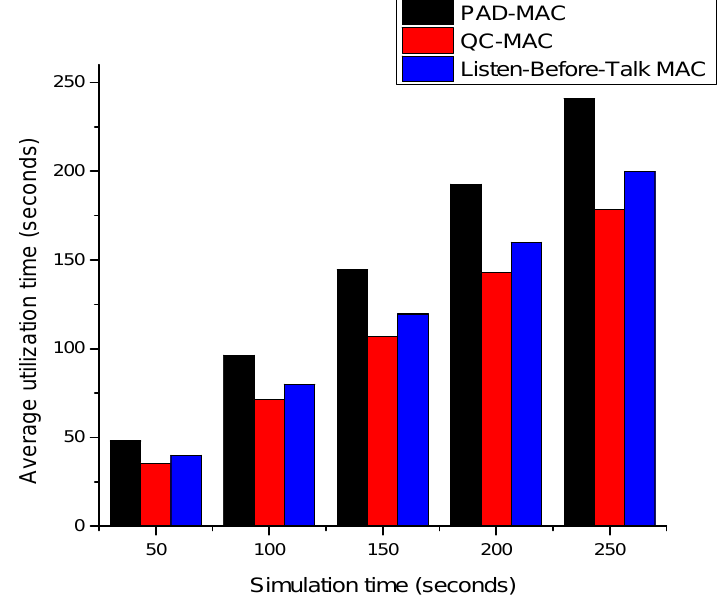
Figure 15. Average SU effective transmission